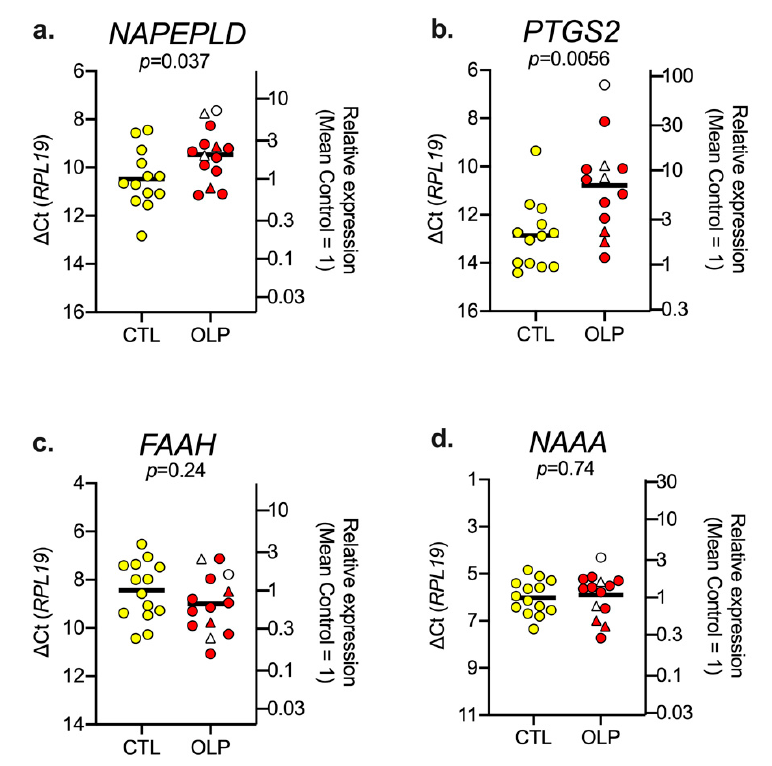
Figure 1. mRNA levels of ( a ) NAPE , ( b ) PTGS2 , ( c ) FAAH , and ( d ) NAAA in biopsy samples from patients with OLP and healthy controls. The data are shown as scatter plots for the healthy controls (yellow circles, CTL) and patients with OLP; in both cases, N = 13–14. For OLP, the triangles are cases without accompanying genital / skin pathology, and the circles are those with accompanying genital / skin pathology. The unfilled symbols are cases without atrophic pathology; the red symbols are cases with atrophic pathology. The y axes have been chosen to give the same span of ∆ Ct values for each mRNA. The bars show the mean values. For the ∆ Ct values, a change of − 1 indicates a doubling in the mRNA content and a change of + 1 indicates a halving. The right y axes illustrate this with respect to the relative expression for the mean ∆ Ct value for the controls. p values are for two-tailed t -tests not assuming equal variance. At a 5% false discovery rate, the critical value of p was 0.0125. In all cases, the residual plots were acceptable.